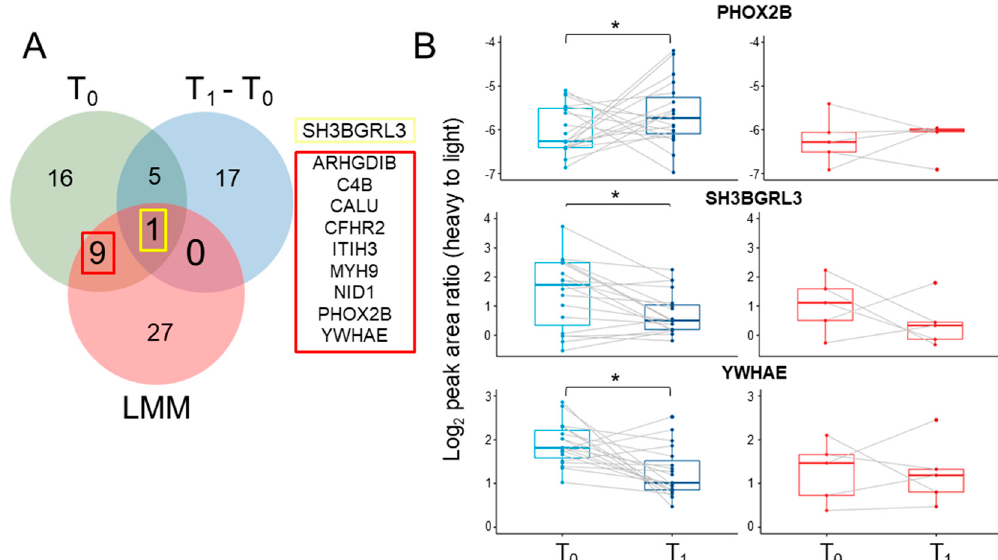
Figure 4. Liquid chromatography-multiple reaction monitoring / mass spectrometry (LC-MRM / MS) validation of ten candidate predictive biomarkers of early-drug response. ( A ) Venn diagram for detection of candidate biomarkers by three statistical analyses (T 0 vs. T 1 and T 1 –T 0 between two groups, and response / time terms in LMM). ( B ) Boxplot of abundance of PHOX2B, SH3BGRL3, and YWHAE at T 1 vs. T 0 , as determined by LC-MRM / MS, in responders (blue color) and non-responders (red color). * The asterisk identifies the adjusted p -values that are significant at the 0.05 level.